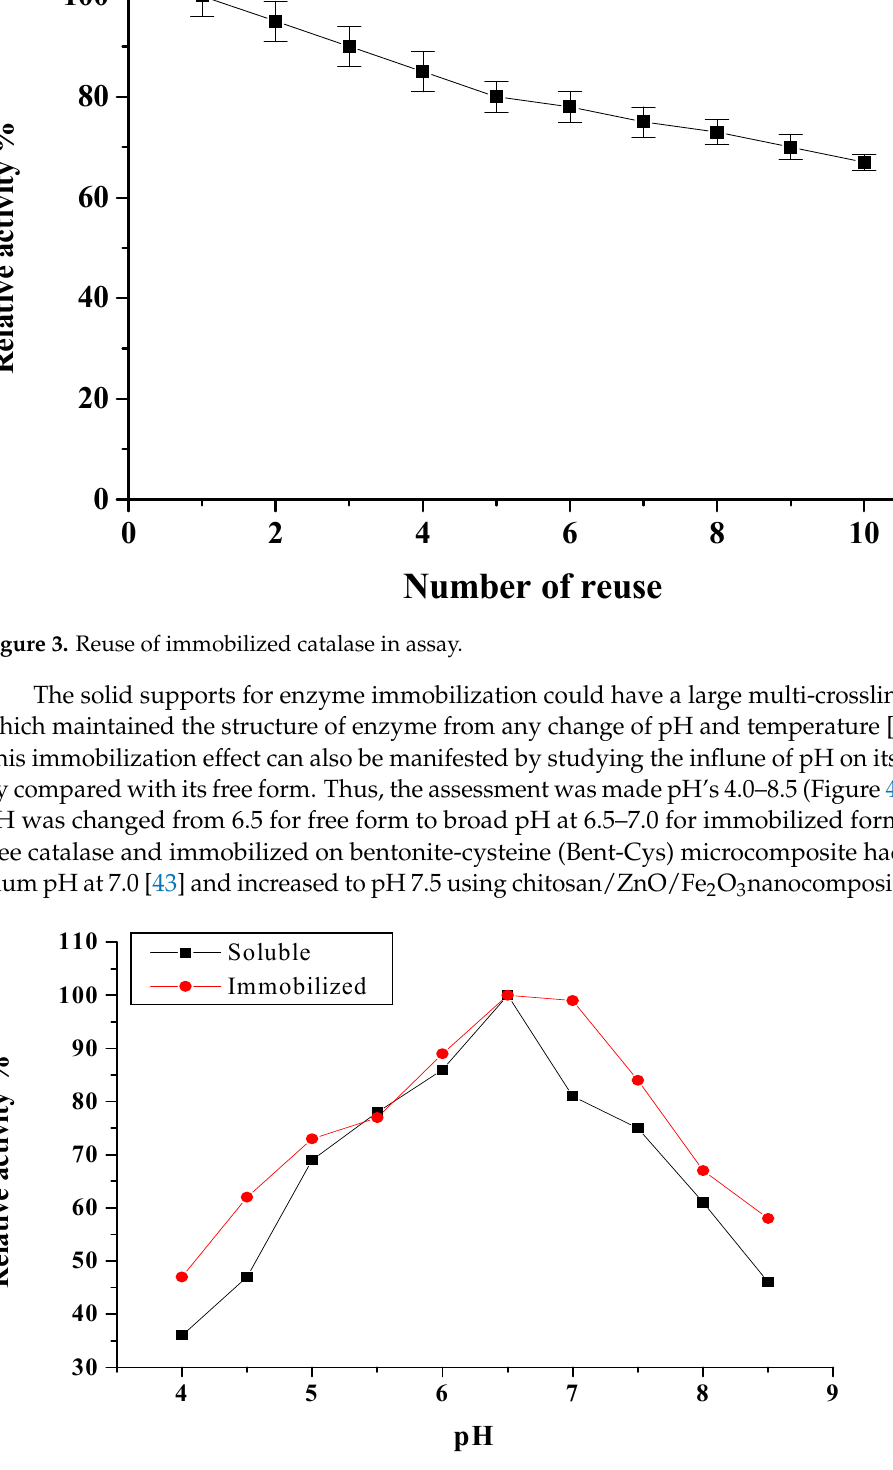
Figure 4. The influence of pH on catalase activity. The influence of temperature on catalase activity is appeared in Figure 5. The opti- mum working temperature increased from 30 for free enzyme to 40 °C for the immobi- lized one. The immobilized catalase on terpolymer (acrylonitrile, acrylic acid, and vinyl porphyrin) was 35 °C, and 25 °C for free catalase [43,44]. The thermal stability study was shown in Figure 6. The soluble form and the immobilized form were steady up to 30 and